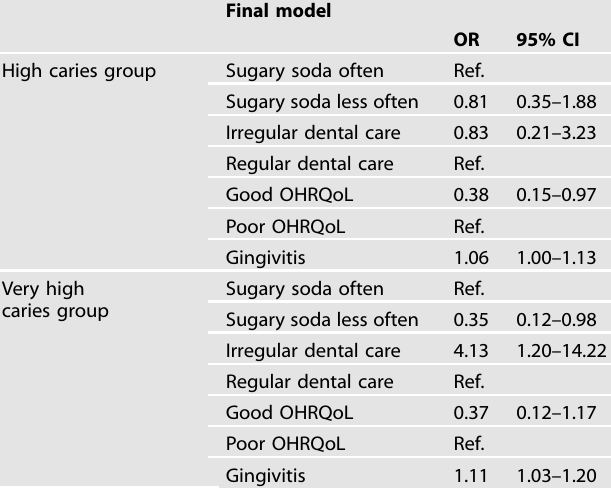
Table 4. Multinomial logistic regression using caries group as the dependent variable with the moderate caries group as the reference group.